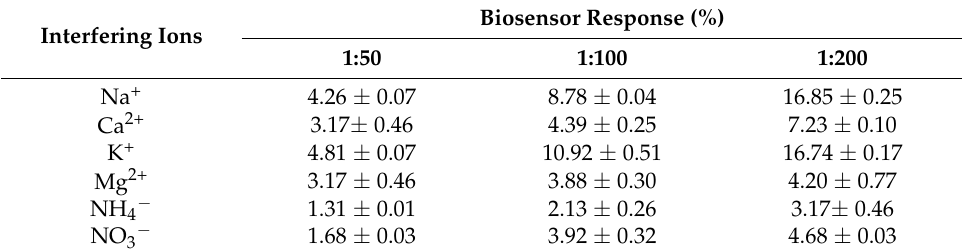
Table 1. The effect of interfering ions on the nitrite biosensor DPV response at − 0.6 V towards the